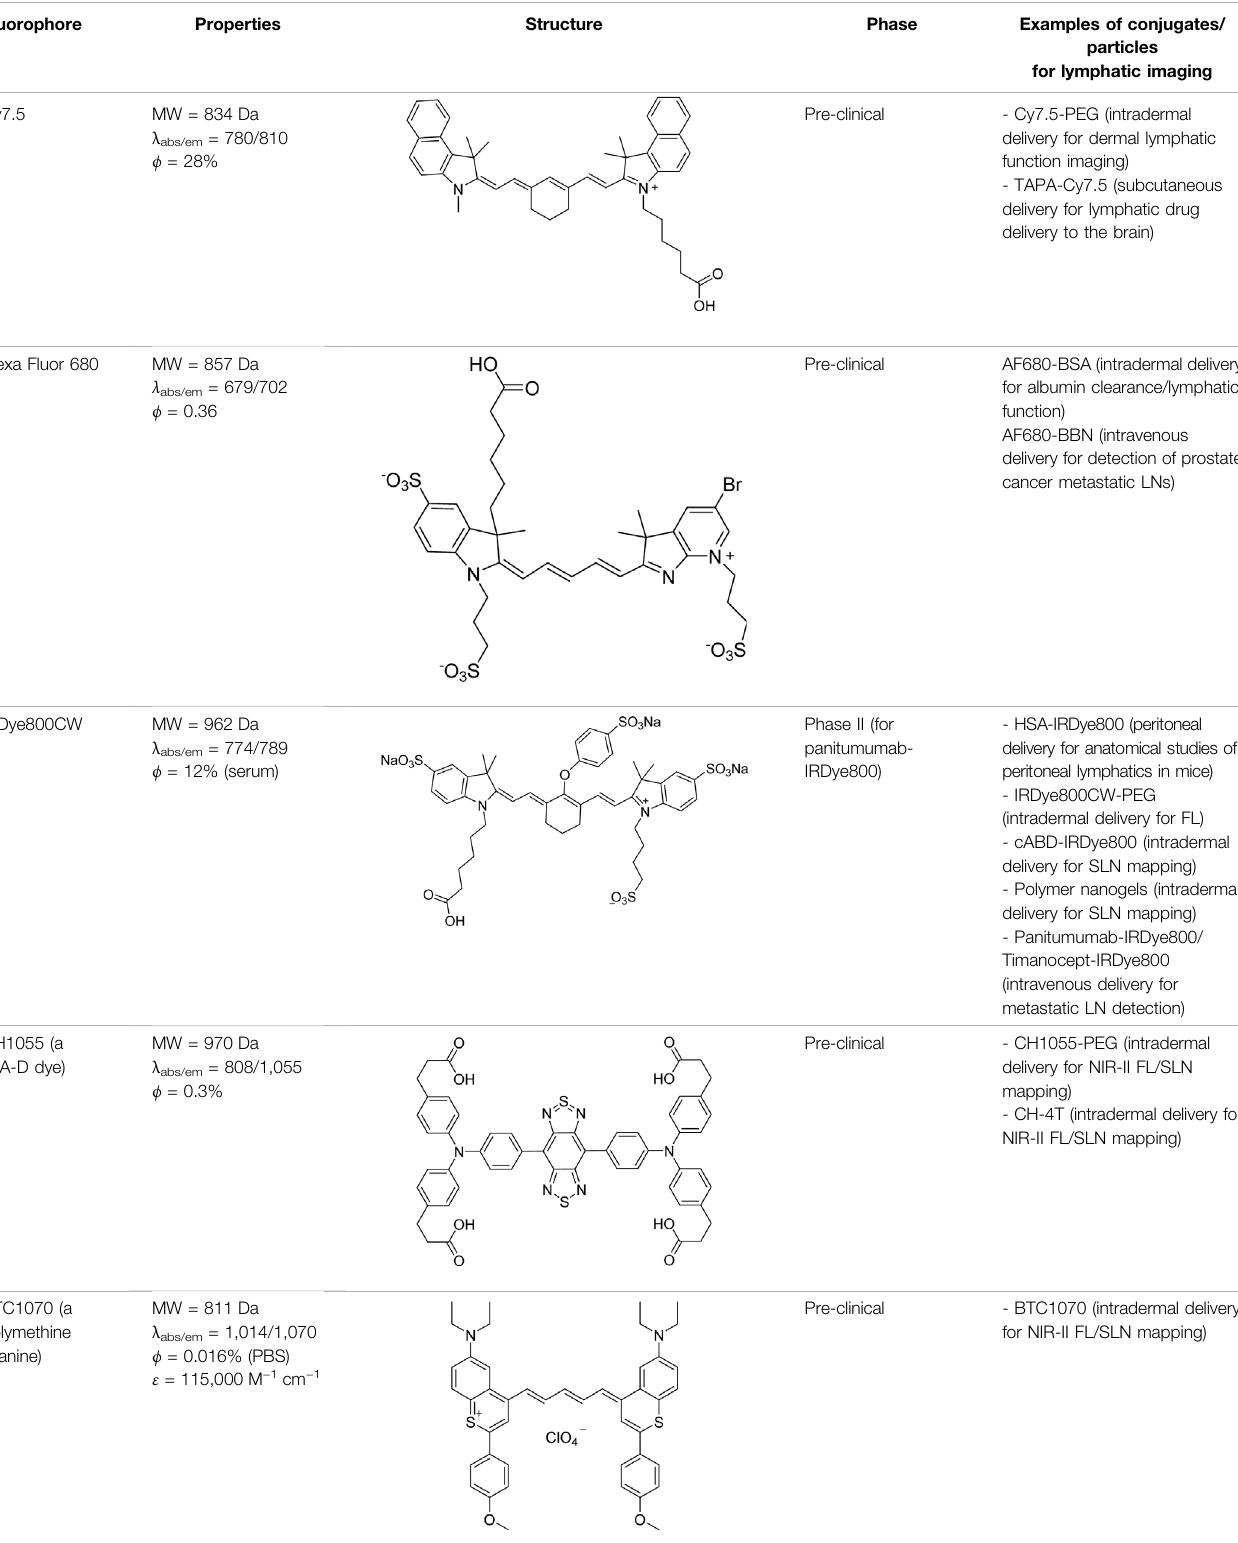
TABLE 2 | ( Continued ) Common fl uorescent tracers used for lymphatic